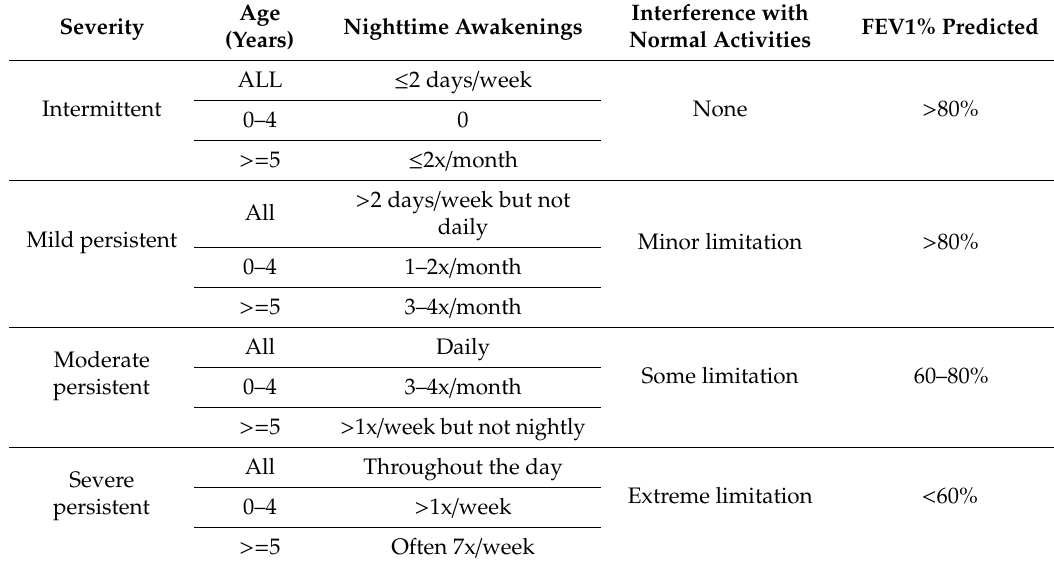
Table 2. Asthma Severity